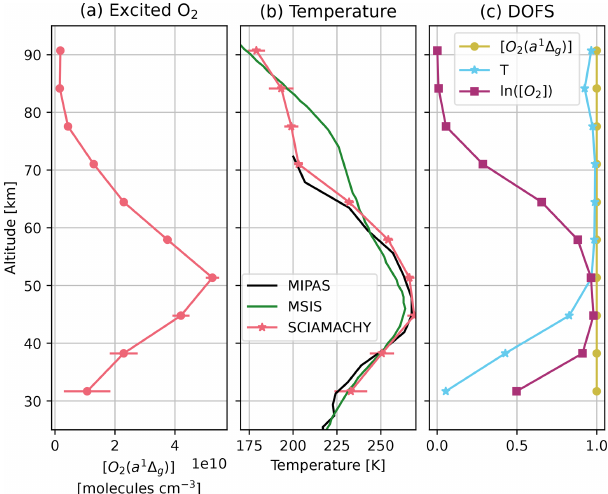
Figure 3. (a) Retrieved [ O 2 (a 1 (cid:49) g ) ] profile from the spectral fit- ting in Fig. 2. (b) Retrieved temperature profile simultaneously with the [ O 2 (a 1 (cid:49) g ) ] (pink), colocated MSIS model temperature (green), and colocated MIPAS observation (black). Error bars indicate twice the posterior error in panels (a) and (b) . (c) DOFS for the retrieved 1 (cid:49) [ O g ) ] , temperature, and ln ( [ O 2 ] ) profiles. Note that the pro- 2 (a files are plotted at the layer center altitude that is ∼ 3.3km above each tangent